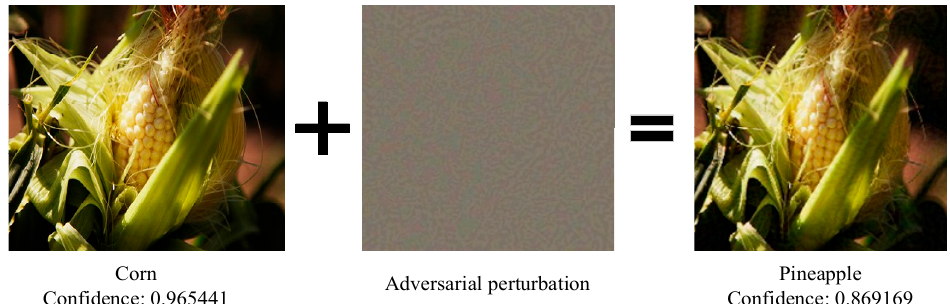
Figure 1. An adversarial example crafted for Inception v3.